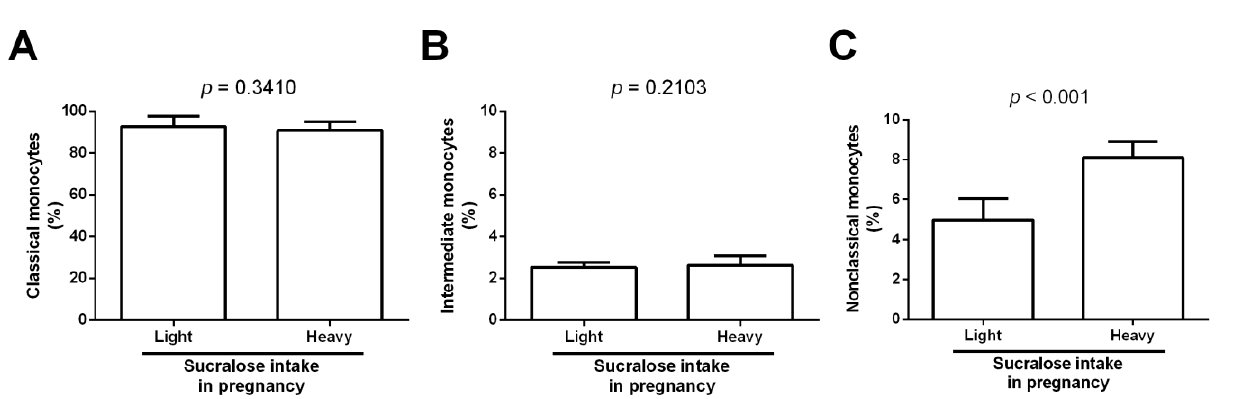
Figure 3. Percentages of classical, intermediate, and nonclassical monocytes in neonates lightly or heavily exposed to sucralose during pregnancy. ( A ) Classical monocyte percentage in newborns lightly or heavily exposed to sucralose. ( B ) Intermediate monocyte percentage in neonates lightly or heavily exposed to sucralose. ( C ) Nonclassical monocyte percentage in newborns lightly or heavily exposed to sucralose. We measured percentages of monocyte subsets in umbilical cord blood from all infants. We expressed data as mean ± standard deviation. We compared data by the unpaired Student’s t -test, considering differences significant when p < 0.05.